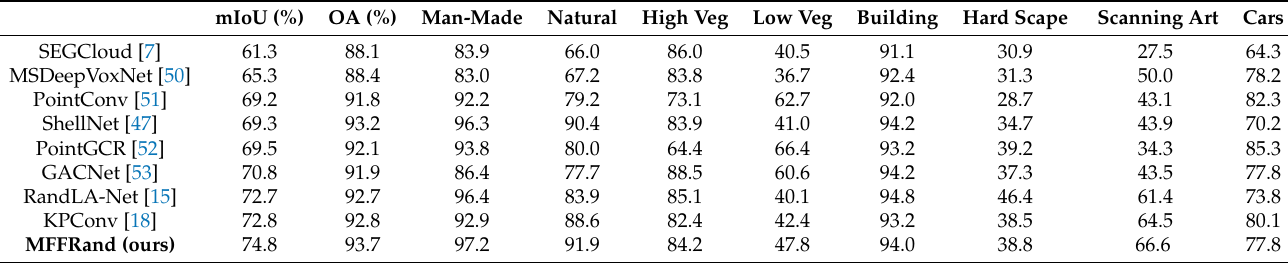
Table 2. Quantitative results of different networks on the Semantic3D